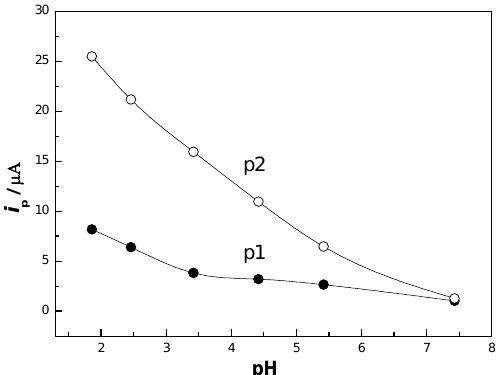
Figure 5. Effect of pH on the anodic peak currents (p1, p2) of 5.0 × 10 -7 M meloxicam at the cysteic acid/GCE. Scan rate: 100 mV·s -1 ; accumulation potential: - 0.2 V; accumulation time: 300 s; quiet time: 30 s; electrolyte: B-R buffer solution (0.04